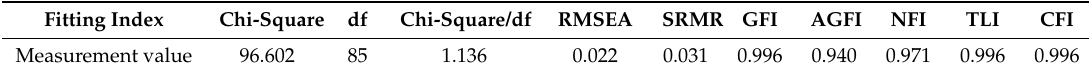
Table 9. Model fitting table.